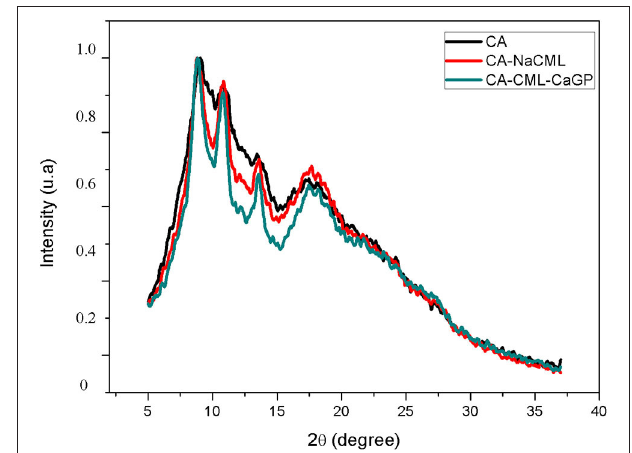
FIGURE 2 | Microscopy images of (A) surface and (B) transversal cross-section of membrane.